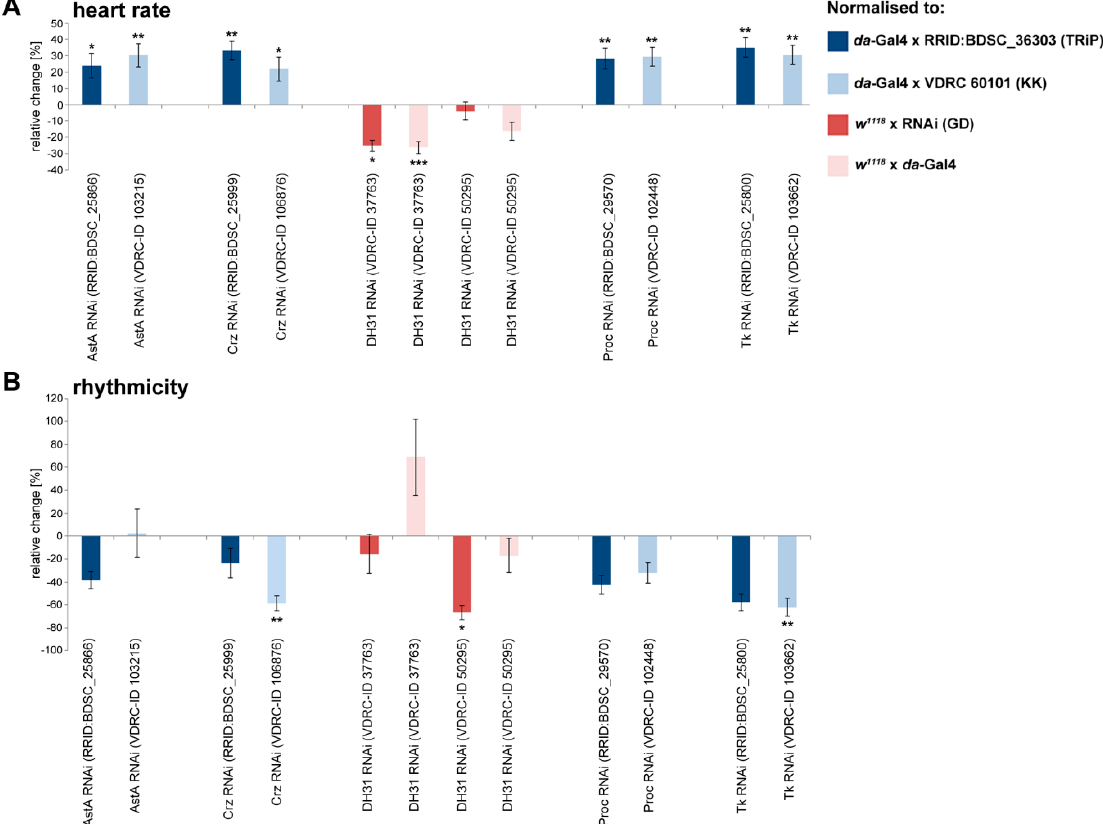
Figure 5. Knockdown of distinct peptide precursor proteins significantly affects heart function in intact Drosophila larvae. Depicted are the individual effects of peptide precursor protein knockdown on ( A ) heart rate and ( B ) rhythmicity. daughterless -Gal4 ( da -Gal4) was used as a ubiquitous driver. Data are presented as mean values (± S.E.M.) of the relative changes in the respective parameters in relation to the depicted controls. At least ten animals per genotype were measured. Significance levels are indicated by asterisks (Student´s t -test, * p < 0.05; ** p < 0.01; *** p < 0.001).